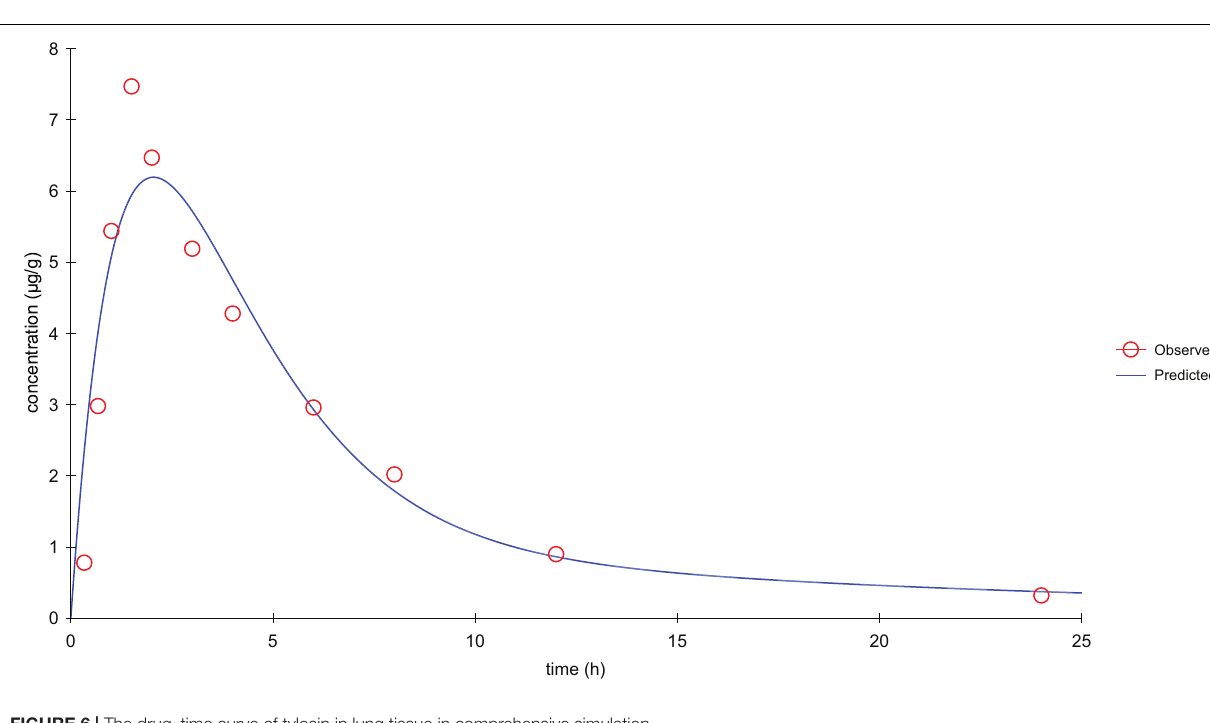
FIGURE 6 | The drug–time curve of tylosin in lung tissue in comprehensive